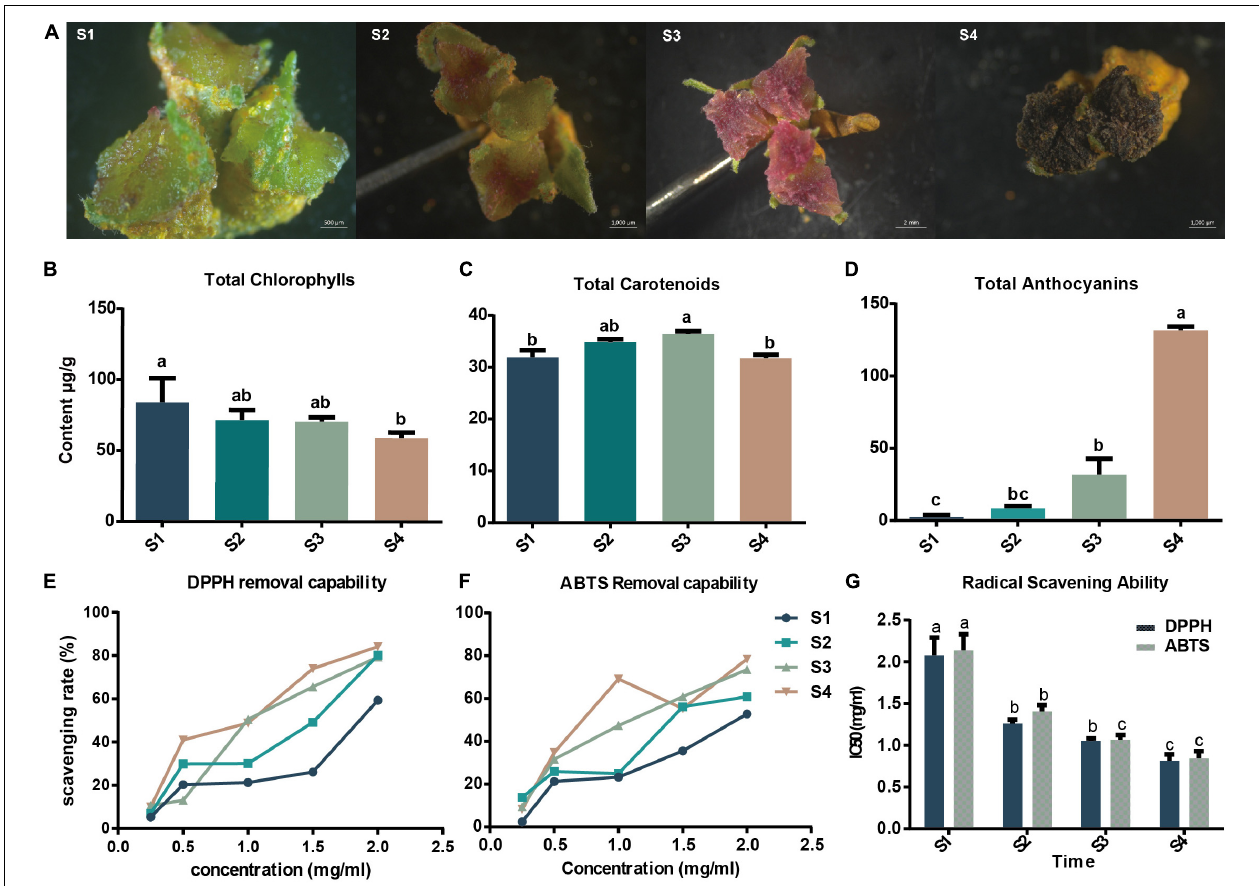
FIGURE 1 | Pigmentation and phenotypes of hickory stigmas at the four flowering stages. (A) Morphological characteristics of hickory stigma during flower development (S1-S4). (B–D) Dynamic changes in the content of total chlorophylls, carotenoids, and total anthocyanins (cyanidin-3-glucoside used as the standard), expressed as µ g/g dry weight (DW). (E–F) Differences in DPPH and ABTS radical scavenging ability in different concentrations of sample extracts expressed as mg/ml. (G) Differences in DPPH and ABTS scavenging capacity at the 4 different stages. Results are mean ± SD of three parallel measurements. Different letters correspond to significant differences ( P < 0.05, Tukey’s HSD) by